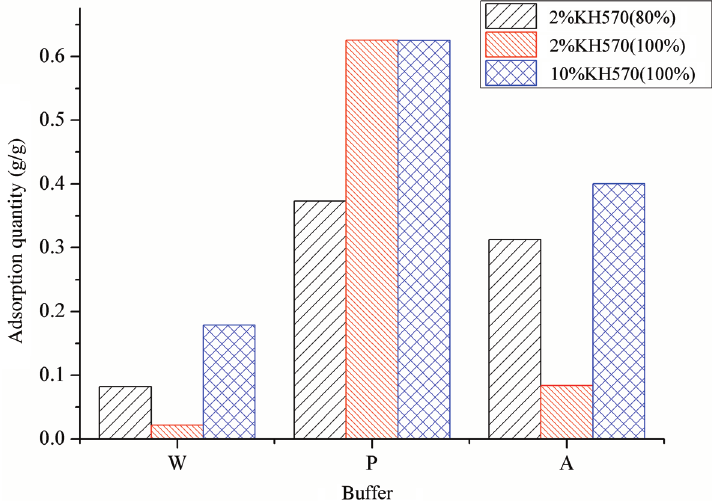
Figure 2 Effect of buffers, KH570 and ethyl alcohol concentrations.